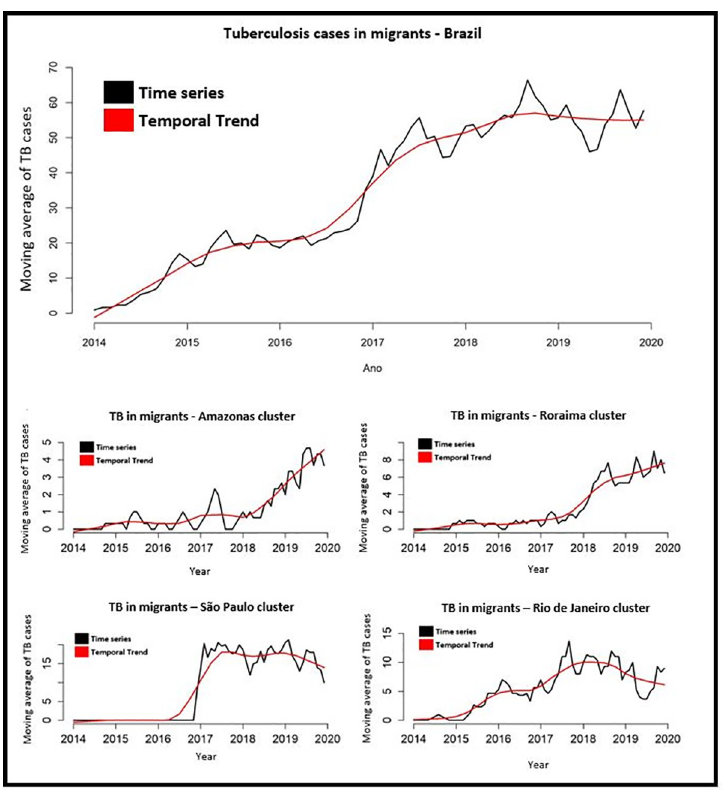
Fig 4. Time series and temporal trend for tuberculosis in migrants in Brazil and in the clusters identified by Getis-Ord Gi � analysis, Brazil (2014–2019). Source: prepared by the authors.